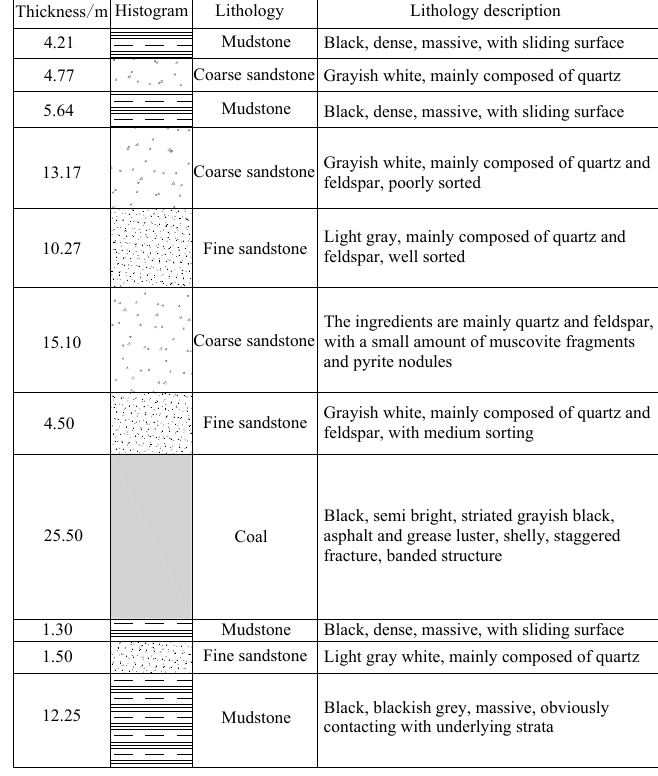
Figure 1. Coal and rock strata histogram.